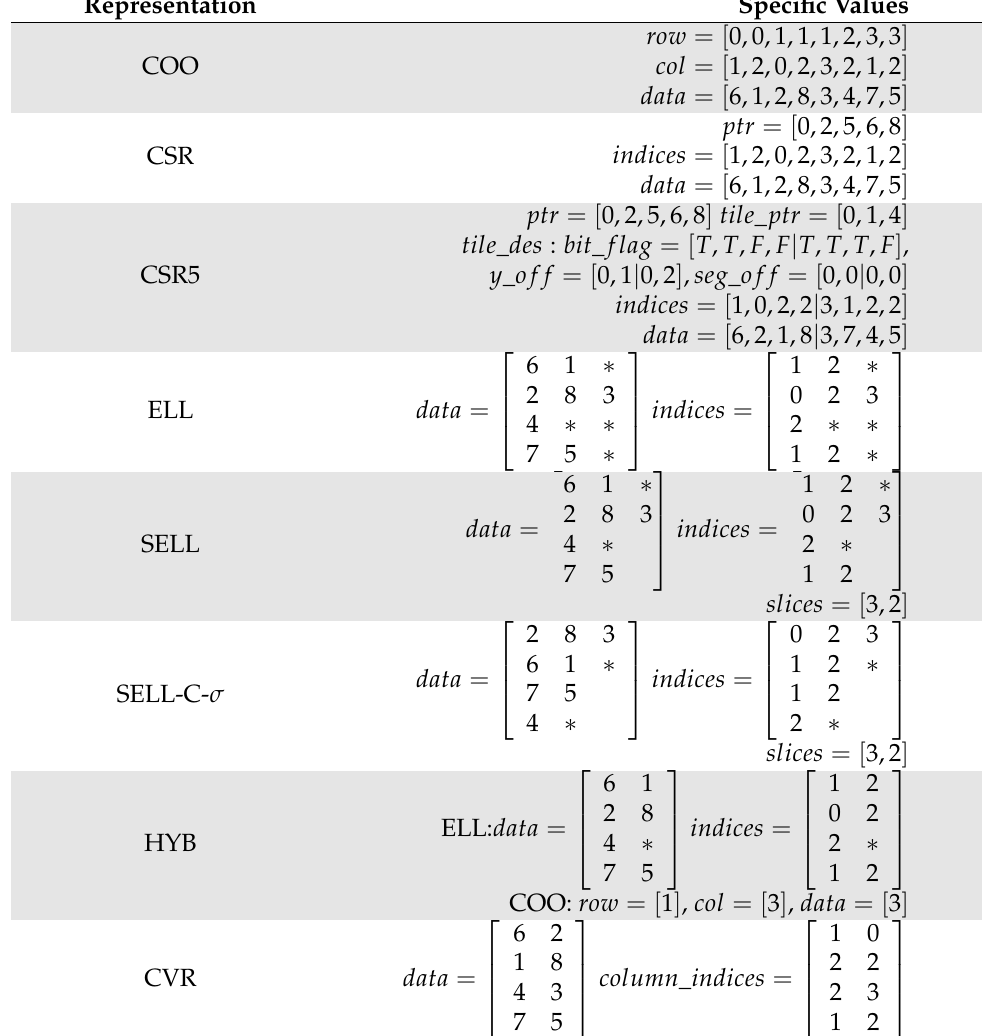
Table 1. Matrix storage formats and their data structures for the sparse matrix shown in Figure 1.